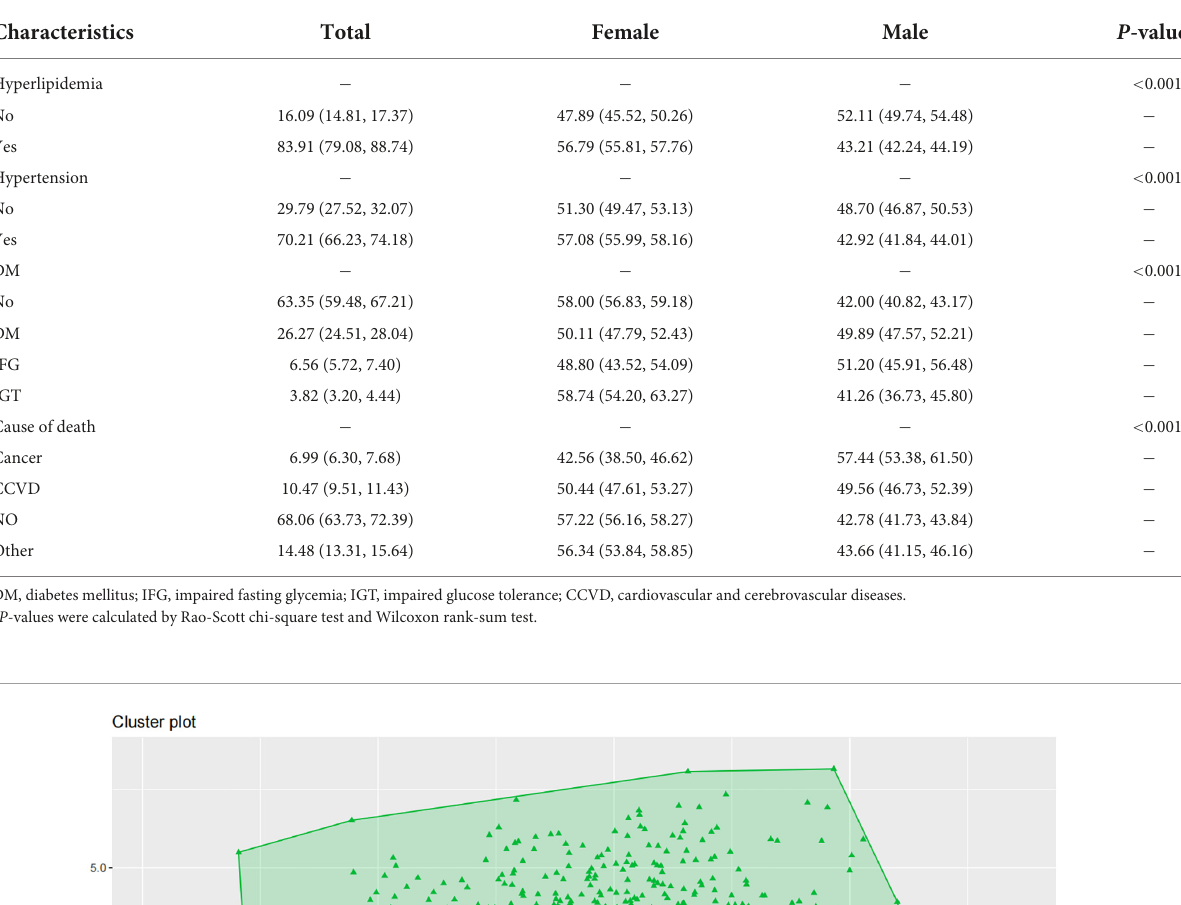
TABLE 2 Baseline disease characteristics of all participants in this study.